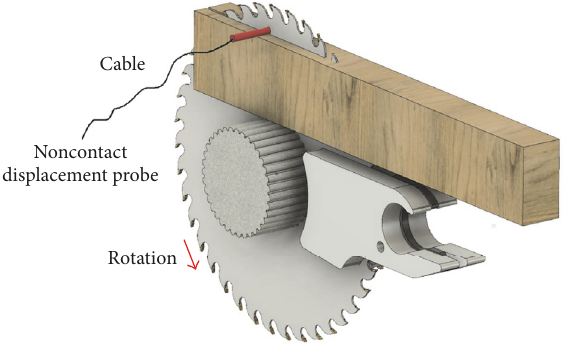
Figure 11: Noncontact displacement sensor, for measuring the saw deflection during a